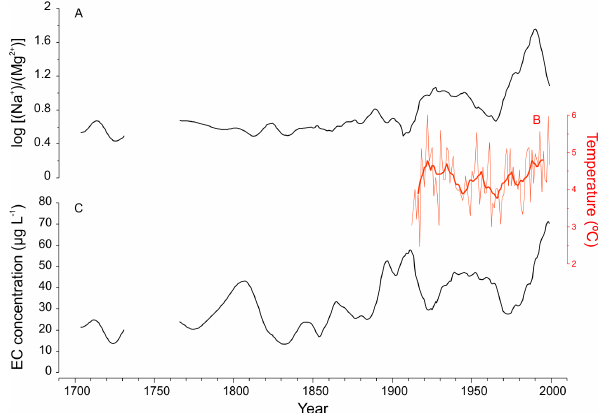
Figure 5. Holtedahlfonna melt index (log ([Na + ]/[Mg 2 + ]) (Beaudon et al., 2013) compared to the measured June–August air temperatures at the Svalbard airport between 1911 and 2000 (source: http://climexp.knmi.nl/), and the EC concentration. The melt index (a) and EC concentration (c) are shown in 10-year run- ning averages using linear interpolations in the resolution achieved by the ice samples. The temperatures (b) are shown in yearly sum- mer resolution as well as 10-year running averages (thick red